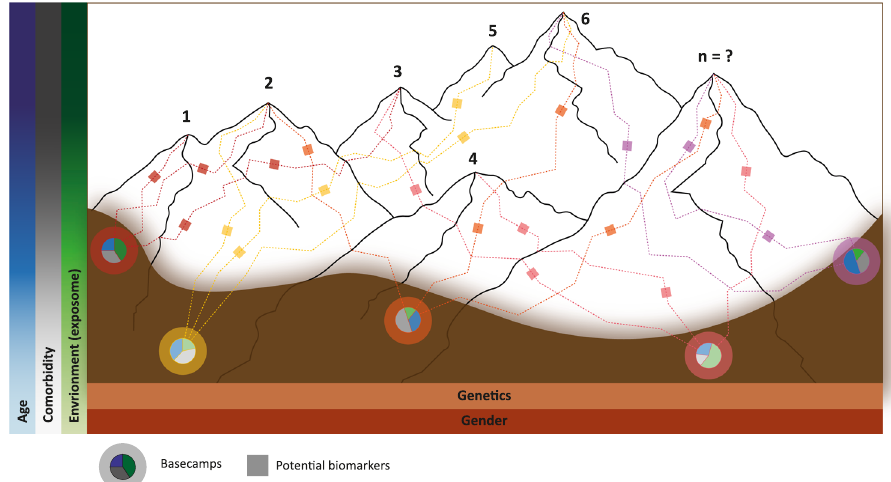
Fig. 1 Parkinson Diseases Mountain Range model. Conceptual model assimilating the different diseases within PD to mountains within a range. There are likely many more mountains (diseases) than presented in this conceptual model. The topology of the valley fl oor represents the total variation in interaction between age, environment, comorbidities, sex and genetics of the population. An individual ’ s genetic risk is represented by the position in the valley (i.e., basecamp) where the individual starts climbing. Different signals (environment, age, comorbidity) from the dynamic basecamp surroundings interact with the individual ’ s genetic factors to alter aspects of the disease including onset age at which the patient begins climbing, or whether the individual even develops PD (re fl ected in the pie charts at base camps). The topology of the mountain (e.g. intrinsic and extrinsic factors) affects how quickly each individual climbs the route (i.e., the rate of disease progression), and thus the range, presentation and severity of symptoms 15 . The small boxes (i.e., checkpoints) along the routes of ascent represent potential biomarkers that could be developed/used to provide an unbiased snap-shot that can be used to track disease development within individual patients. However, these ‘ on route ’ biomarkers will likely change over the course of the